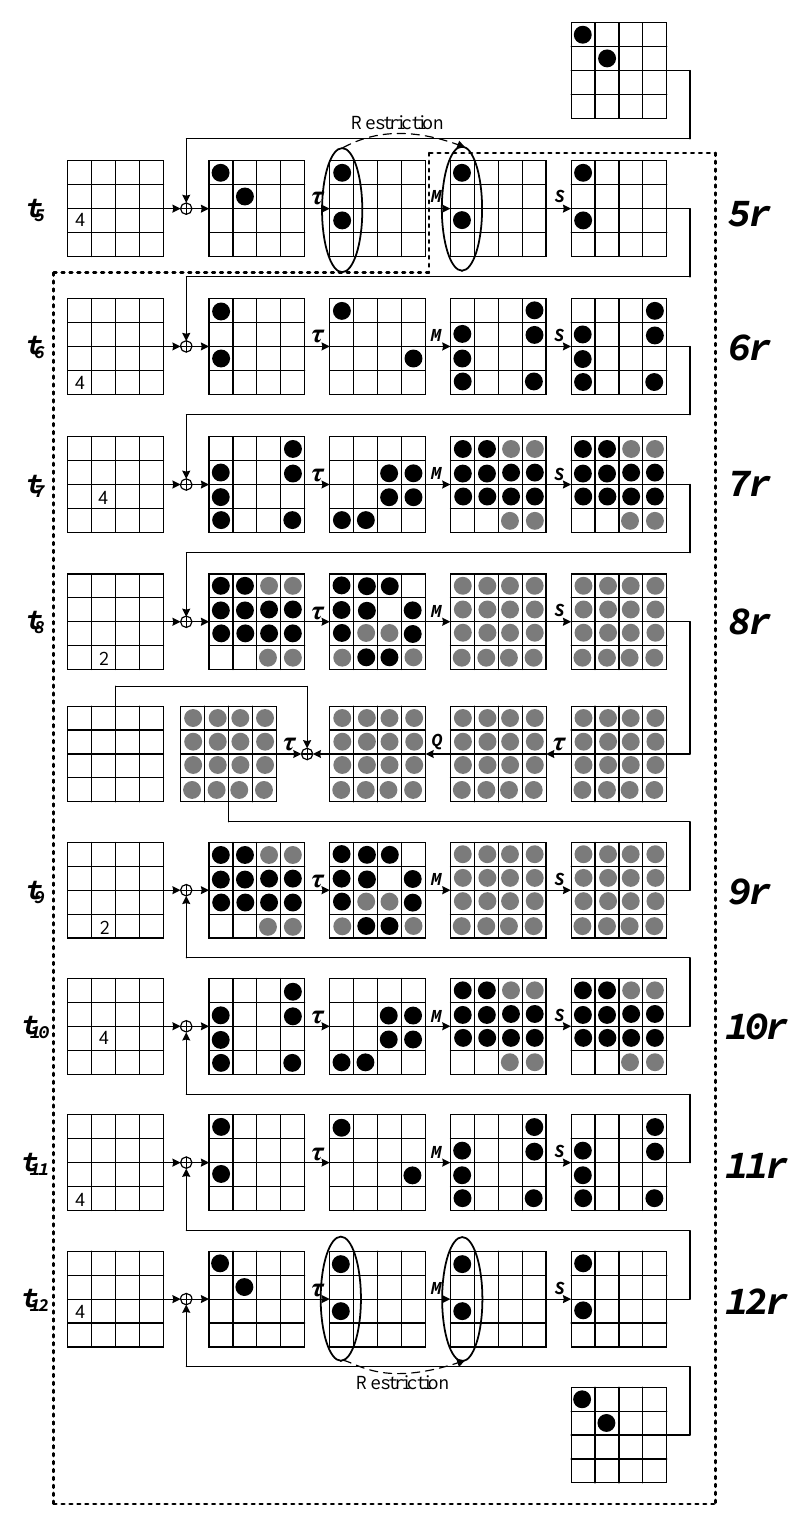
Figure 4: TDIB Distinguisher for 8-Round QARMA -64. White words are non-active ones, while black ones are active words. And gray words can be active or